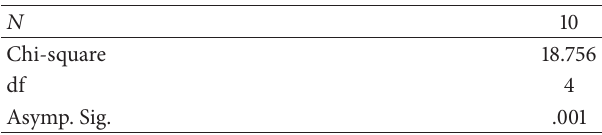
Table 6: Test statistics a .